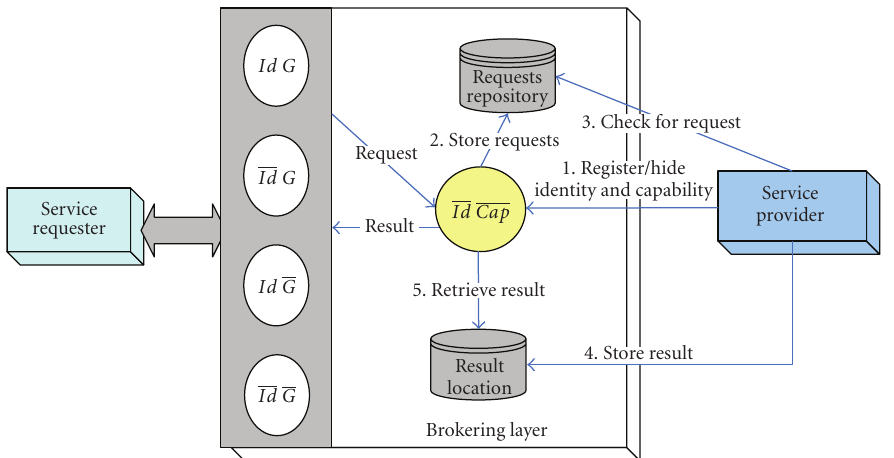
Figure 9: Interaction pattern for provider hiding privacy